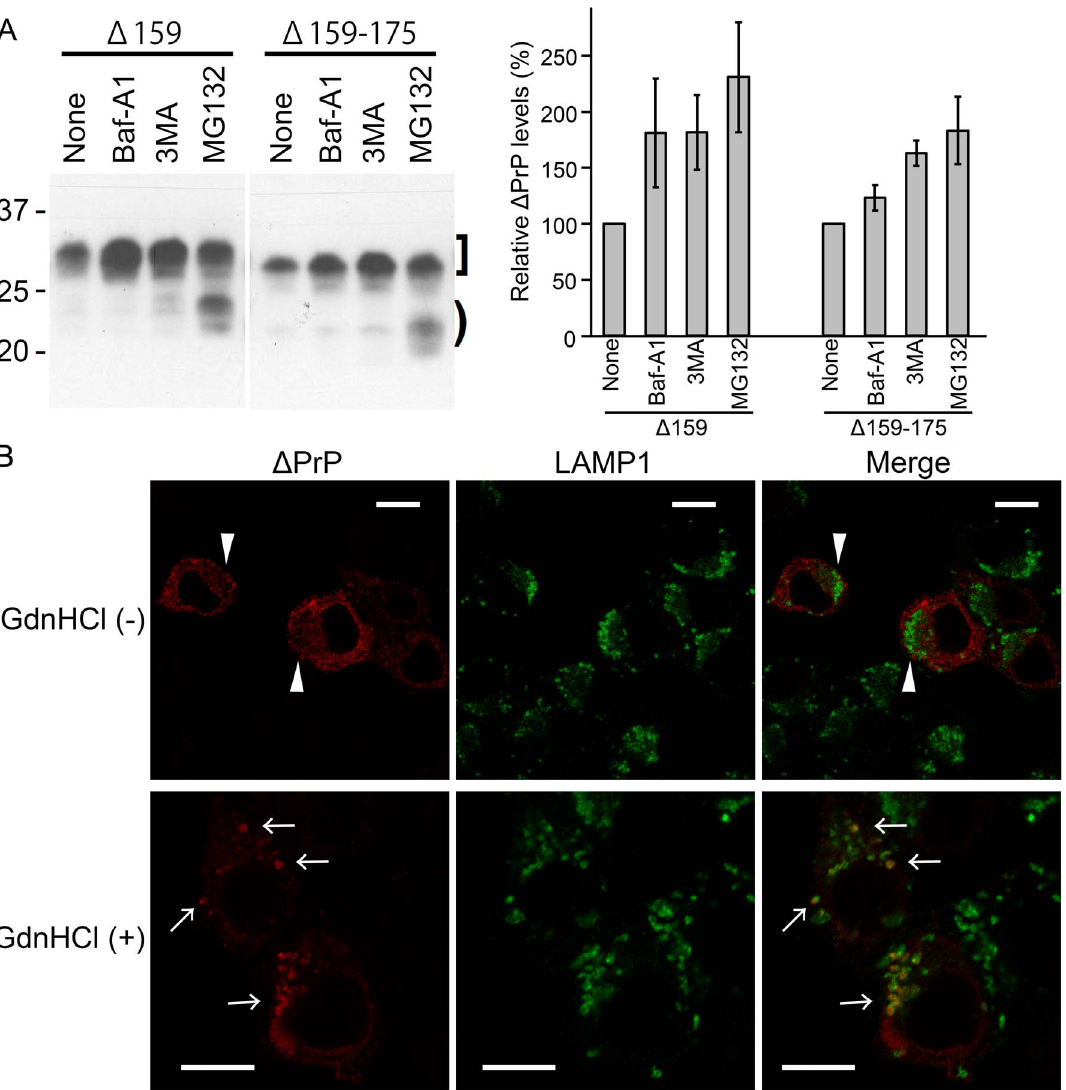
Figure 5. D PrPs are degraded by both lysosomal and proteasomal degradation systems. A. Degradation of D PrPs by lysosomal and proteasomal systems. (Left) N2a cells transiently transfected with D 159 or D 159–175 were treated for 7 hours with inhibitors either for lysosomal degradation (bafilomycin A1, Baf, 120 nM), autophagy (3-methyladenine, 3MA, 10 mM), or the proteasome (MG132, 10 m M) and cell lysates analyzed in immunoblot for expression of D 159 and D 159–175 (mAb 3F4). Square bracket and bracket denote diglycoforms and nonglycoforms of D PrPs, respectively. An increment in diglycoforms is observed in Baf- and 3MA-treated cells, whereas in MG132-treated cells also the non-glycoforms are increased. (Right) A graph showing quantification of all PrP bands by densitometric analysis. Data from 3 independent (one in duplicate) experiments for D 159 and 2 independent (one in duplicate) for D 159–175 were statistically analyzed for mean and standard deviation (error bars). B. D PrPs can be localized in LAMP1-immunopositive vesicles. Immunofluorescence analysis shows distribution of D PrP (mAb 3F4) and LAMP1 in cells with or without 6M GdnHCl antigen-retrieval treatment. N2a cells transfected with D PrP159 were fixed, permeabilized and incubated without (upper panel) or with 6M GdnHCl (lower panel). With GndHCl treatment D PrP is diffusely distributed (arrowheads) and co-localizes poorly with LAMP1. After GdnHCl treatment (lower panel), bright 3F4-immunopositive puncta (arrows) are observed which partly co-localize with LAMP1-positive structures (merge). Scale bars, 10 m